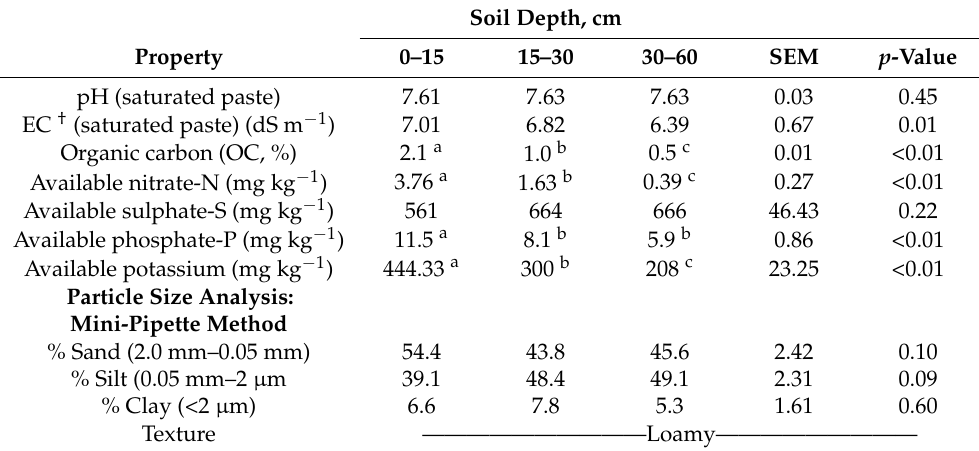
Table 2. PhysicochemicalpropertiesofsoilatthreedepthsbeforeseedinginClavet, Saskatchewan,Canada.